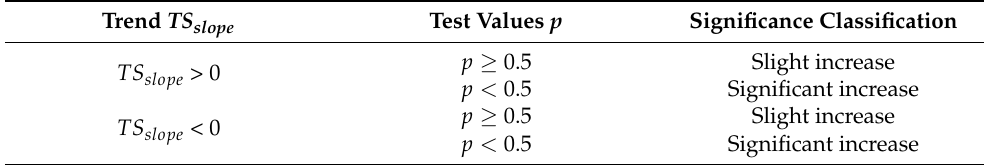
Table 2. Sen + MK trend description and significance grading used in this study. Trend TS